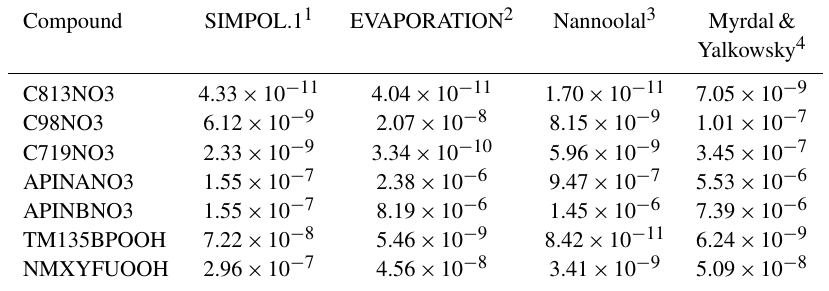
Table 3. Comparison of pure component vapor pressures (atm) estimated (at 298K) for the most abundant CONO 2 compounds in the aerosol phase for the APIN-hNO x simulation. Calculations were accessed using the UManSysProp tool (Topping et al.,